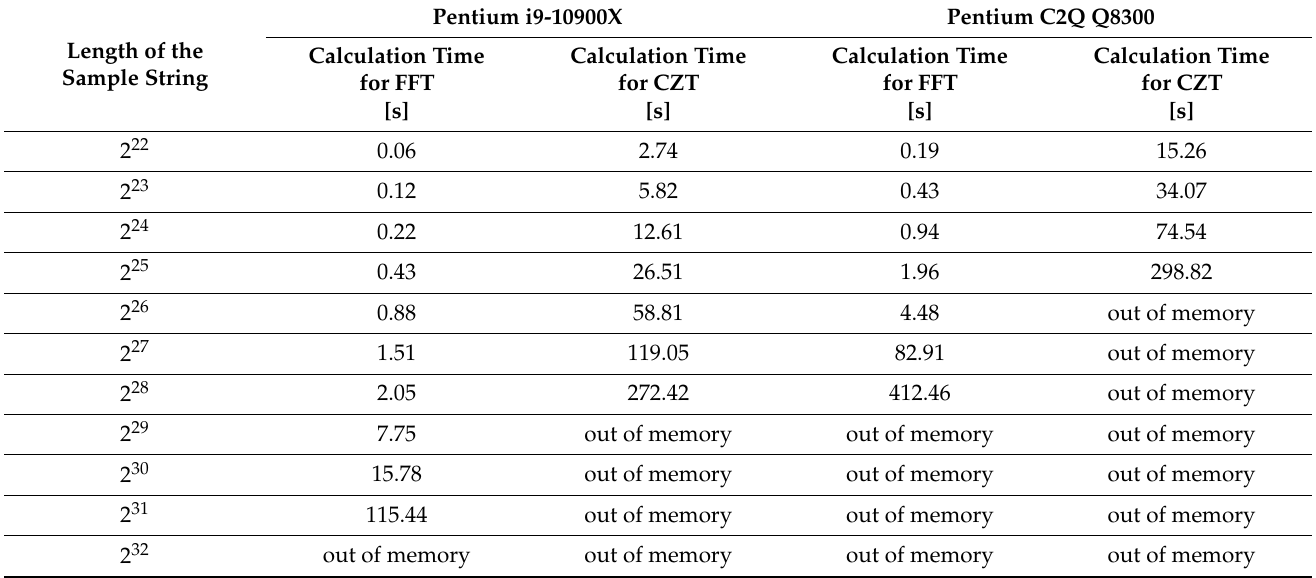
Table 2. Average FFT and CZT transform computation time for exemplary hardware